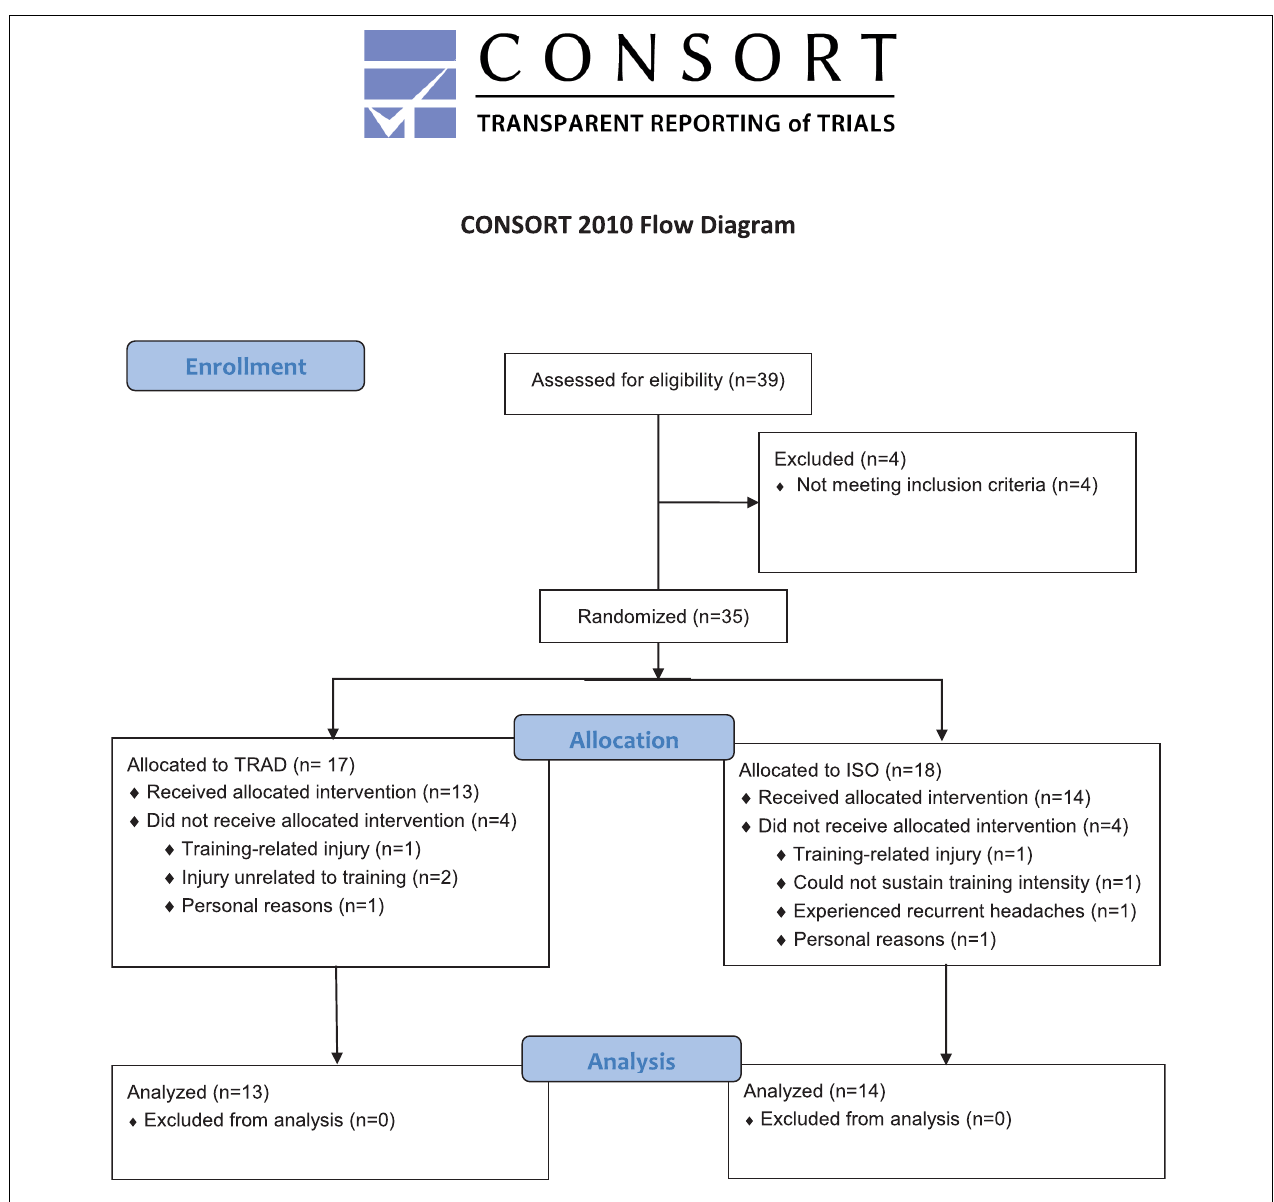
FIGURE 1 | CONSORT flow